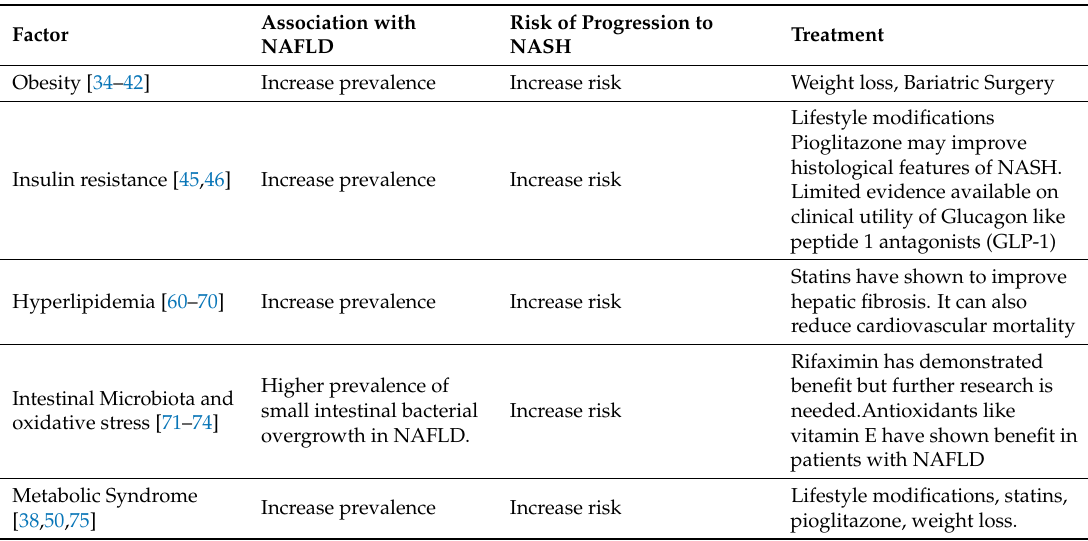
Table 3. Modifiable risk factors for